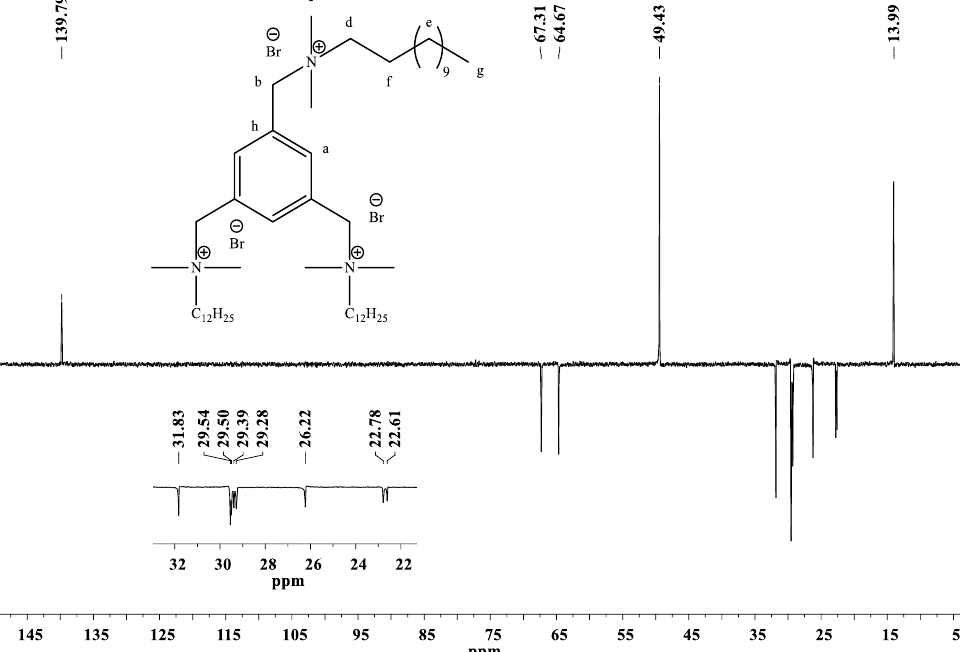
Figure 2. 13 C DEPT spectrum of 1,3,5-tris[( N -(1-dodecyl)- N , N -dimethylammoniummethyl)benzene tribromide ( 14 ).